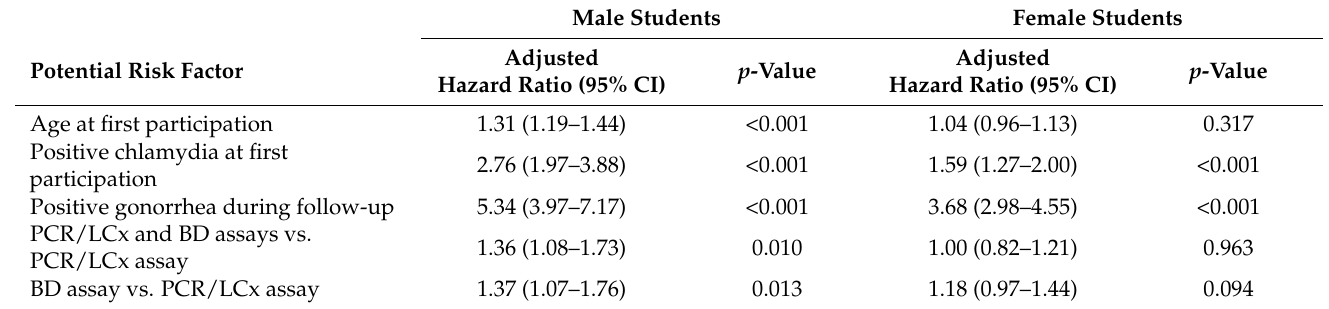
Table 3. Cox proportional regression analyses of incidence rates among male and female